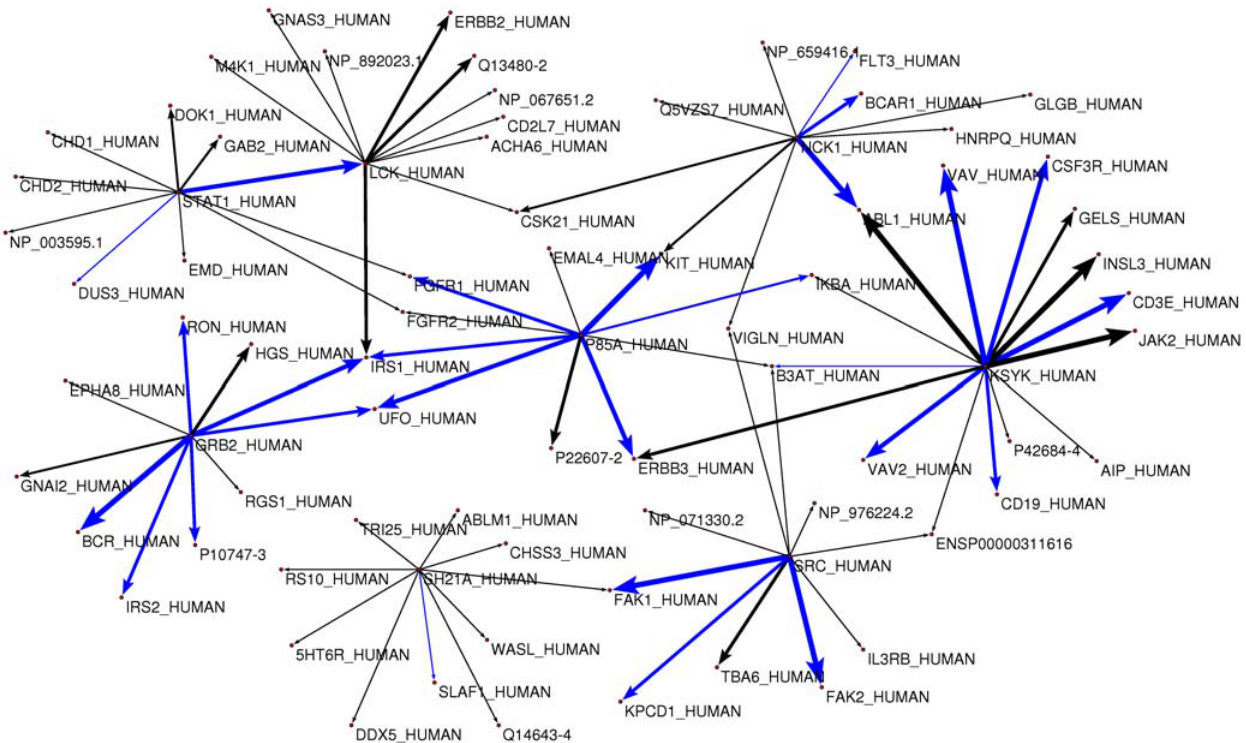
Figure 5. High-confidence predictions of SH2-mediated protein-protein interactions. Arrows depict the predicted interactions from SH2- containing proteins to the top 10 putative targets. The 15 predictions for Syk (KSYK_HUMAN) correspond to the top 10 predictions for both the N- terminal and C-terminal SH2 domains. Both domains were predicted to bind B3AT_HUMAN, ERBB3_HUMAN, VAV_HUMAN, CD19_HUMAN, and IKBA_HUMAN. Interactions confirmed by experimental evidence are highlighted in blue. The thickness of the line is proportional to the odds that the proteins interact in vivo as calculated by the naive Bayes network. The exact odds score and the source of the supporting evidence found for each particular interaction is detailed in Table S6. Eight alpha-tubulin subunits were predicted to interact with the Src SH2 domains, and seven guanine nucleotide binding subunits were predicted to interact with the Grb2 SH2 domain. In both cases, these predictions are depicted as a single arrow. upgraded version of FoldX can predict six different kinds of experimental results: the effect of dephosphorylation (Table S1) and of mutations in the environment of the peptide group on the stability of the complex (Figure 1), the consensus target sequence for the domain (Table 1), the in vitro binding specificity (Figure 2) and how it changes upon mutation of the SH2 domain (Table 2) and in vivo SH2-mediated protein-protein interactions (Figure 3).